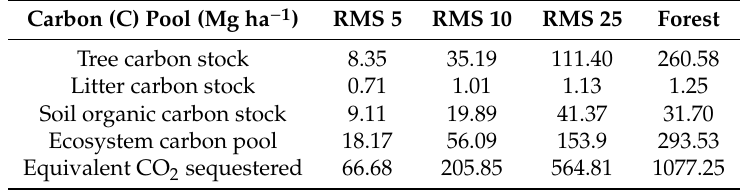
Table 7. Partitioning of carbon pool (Mg C ha − 1 ) in di ff erent ecosystem components.